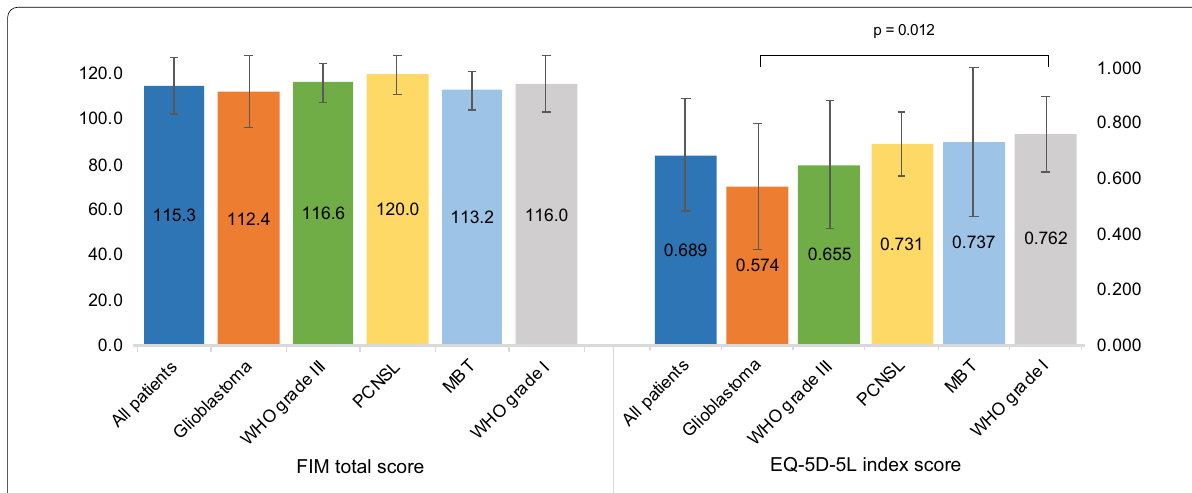
Fig. 1 Comparison of FIM and EQ-5D-5L index score in tumor classification. PCNSL: Primary central nervous system lymphoma, MBT: Metastatic brain